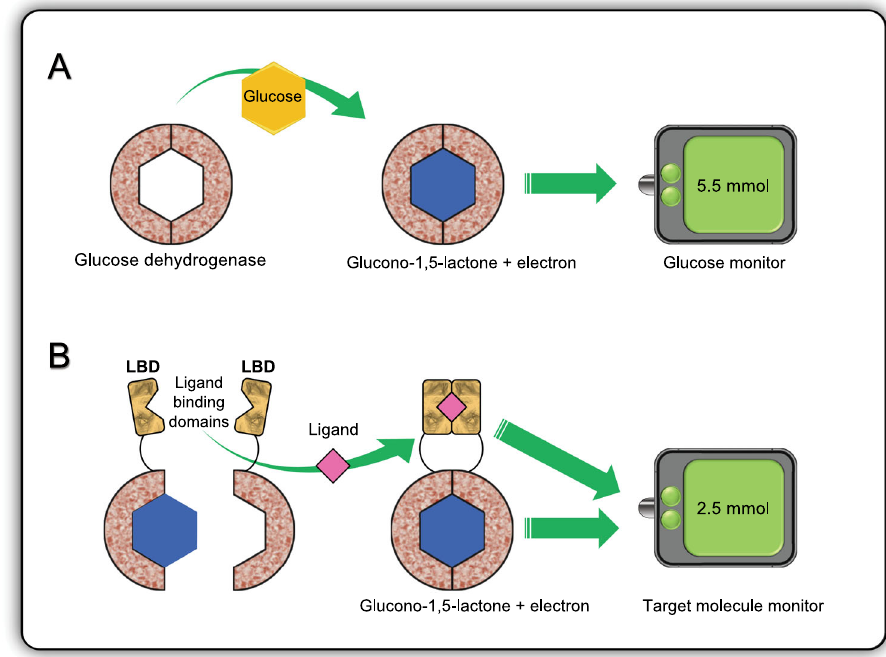
Fig. 2 Engineering ligand-binding domains creates opportunities for translating the biosensing of target molecules into digital signals. ( A ) Pyrroloquinoline quinone glucose dehydrogenase (GDH) releases an electron in the presence of glucose, which can be detected using an electrode in a blood-glucose monitor. ( B ) Split GDH fused to ligand-binding domains (LBDs) for another molecule can be used as a generic biosensor, as the GDH domains can only co-localize to release an electron when the fused LBDs bind to a molecule of